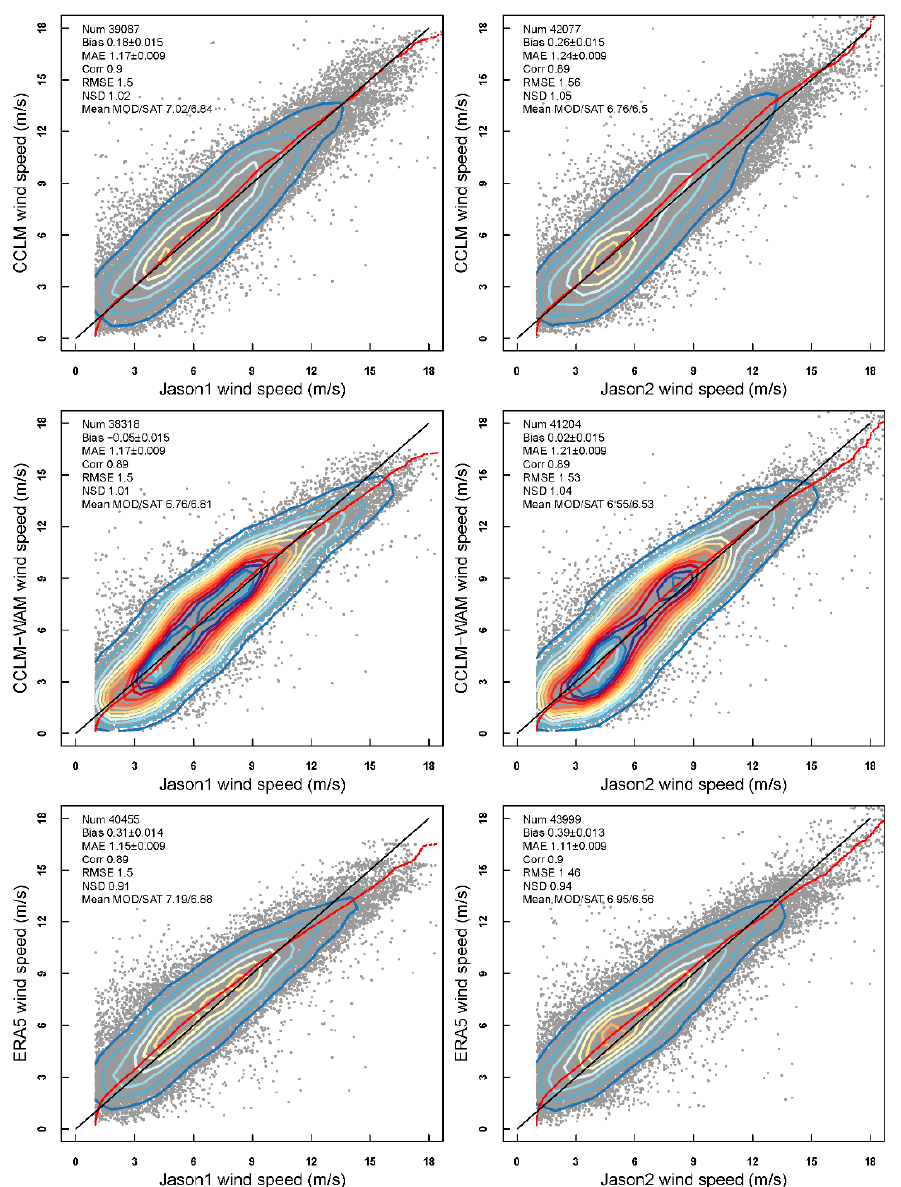
Figure 7. Comparison of modeled wind speed (y-axis) with Jason-1 (left column) and Jason-2 (right column) satellite wind observations (x-axis): Scatter plots (grey dots), qq plots (red dots), and several statistical measures (valid numbers of observations, bias, mean absolute error (MAE), correlation (Corr), root-mean-square error (RMSE), mean and normalized standard deviation (SD)). The kernel density estimations (contour lines) are included. Furthermore, 95% confidence interval of bias and MAE are listed.